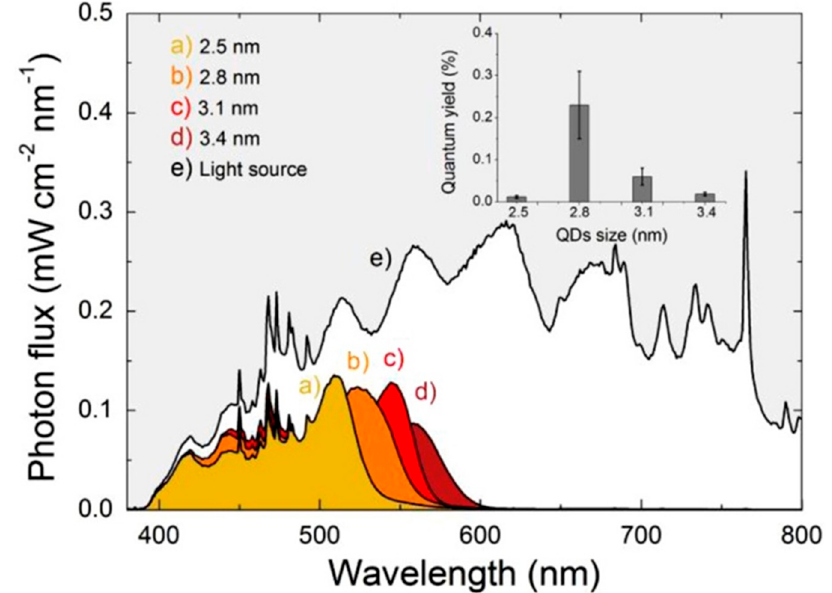
Figure 10. UV–vis absorption spectra and quantum yields of CdSe quantum dot photocatalysts with various size . Figure adapted from [128].